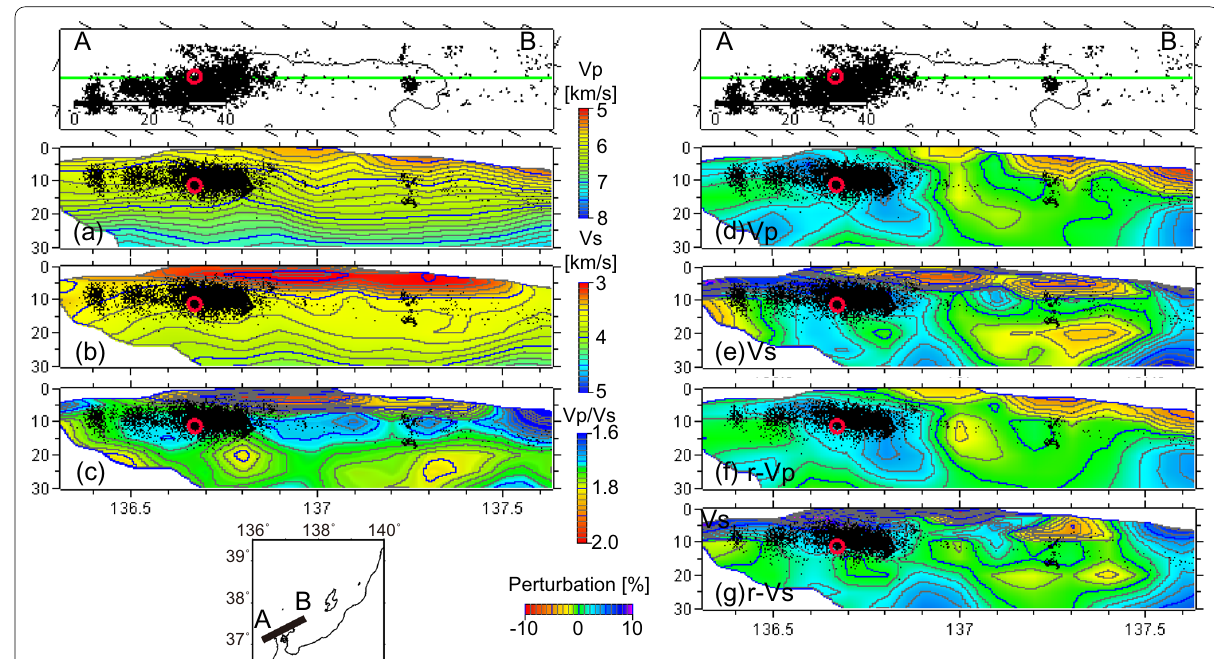
Fig. 19 Seismic velocity structure and restored resolution test around the 2007 Noto Peninsula earthquake. Red circles denote the hypocenter of the 2007 Noto Peninsula earthquake determined with 3D